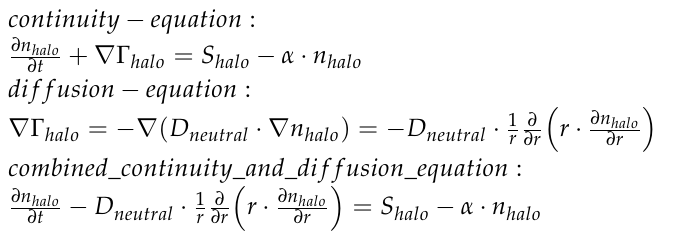
Figure 11. Atoms 2019 , 7 , x FOR PEER REVIEW